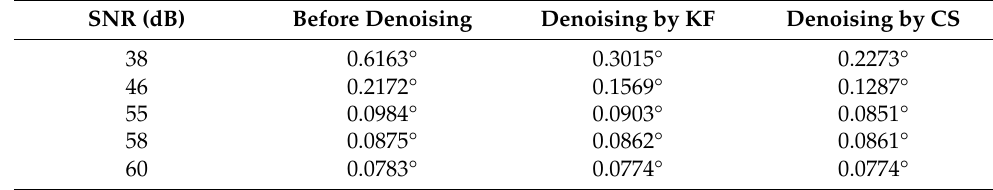
Table 4. Synchronization